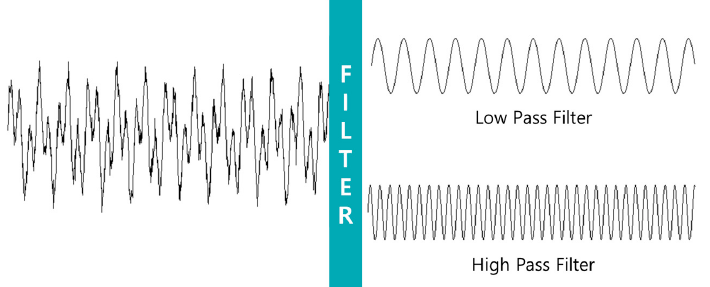
Figure 2. Concept of Filtering.